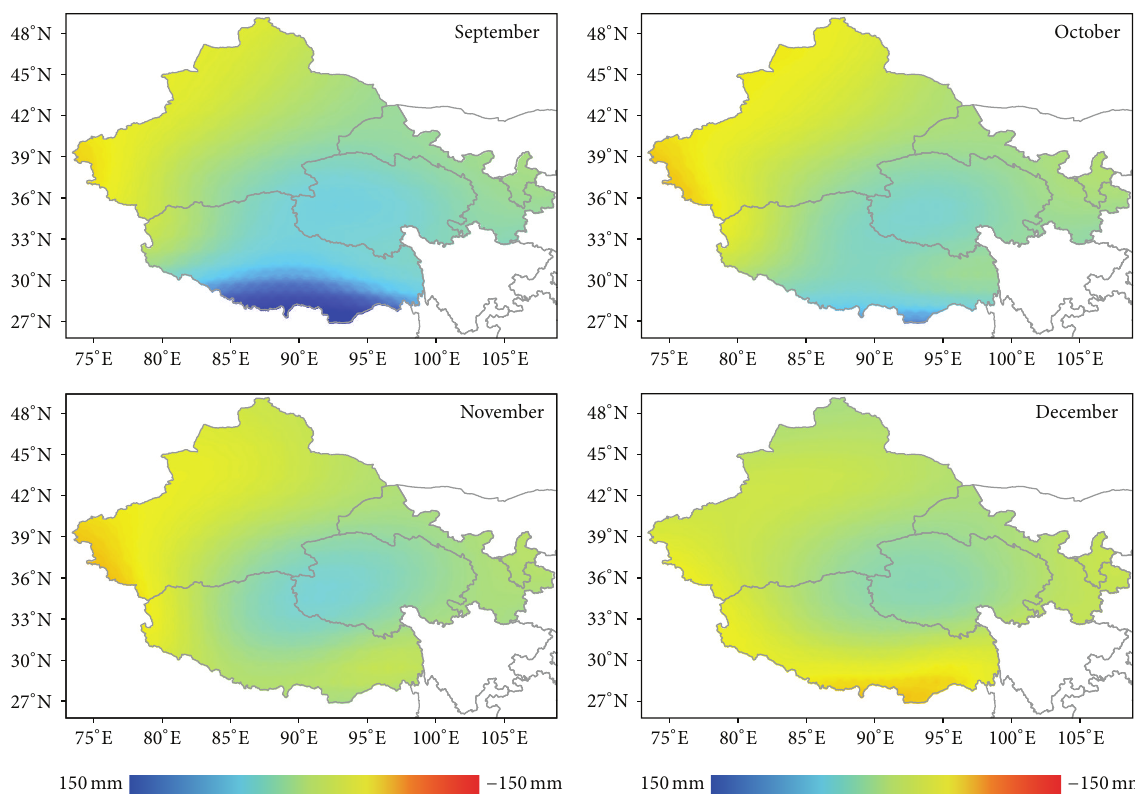
Figure 6: Monthly averages of WSC from 2003 to